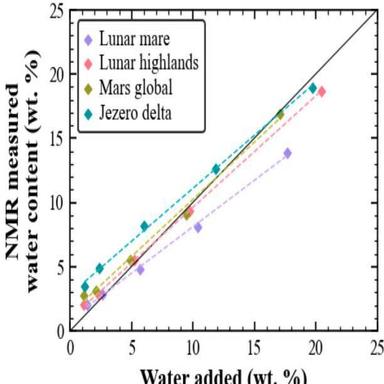
Comparison of the NMR measured water content to the gravimetrically measured water added. The data is fit using a linear regression (dashed lines) for each sample: the slope, intercept and coefficient of determination (R2 ) are quantified in the associated table. The solid black line indicates the line of equivalence for reference.